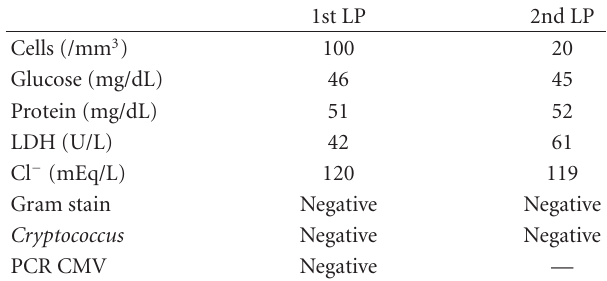
Table 1: Comparison of the lumbar puncture